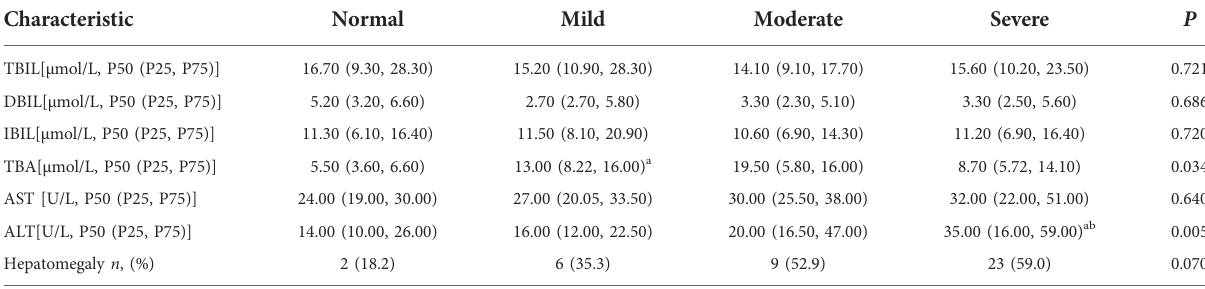
TABLE 4 Comparison of liver structure and function.